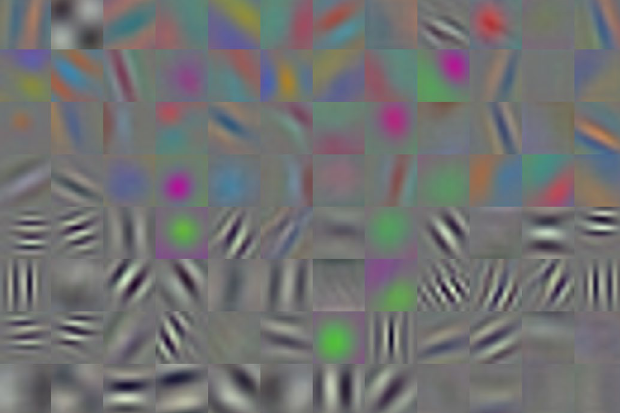
Fig. 7. The first layer weights have a well-defined structure used in